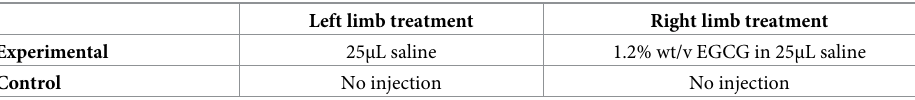
Table 1. Treatment groups of nanoindentation study.